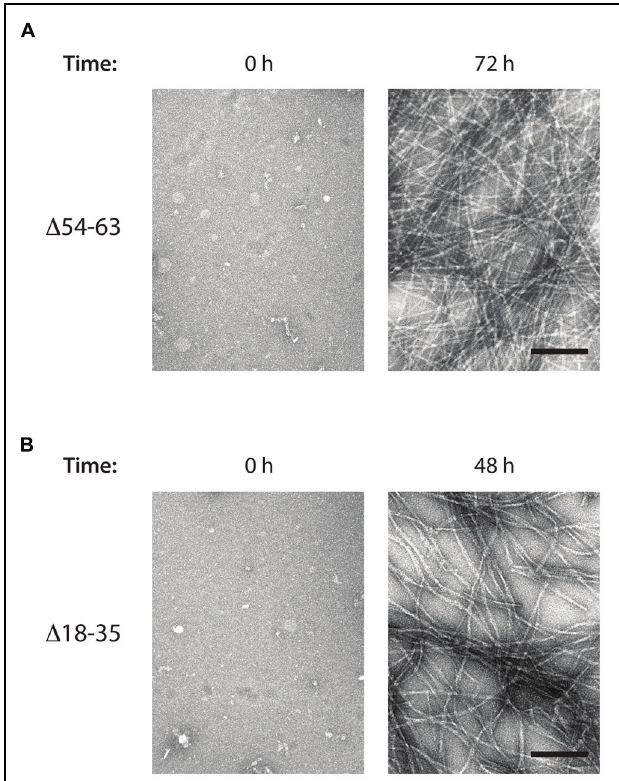
FIGURE 7 | MccE492 mutants (cid:2) 18–35 and (cid:2) 54–63 preserve the ability of forming amyloid fibrils in vitro . Negative-stain electron microscopy visualization of amyloid fibers formed by the MccE492 variants (cid:2) 54–63 (A) or (cid:2) 18–35 (B) , incubated in aggregation buffer until the indicated time. Scale bar: 100